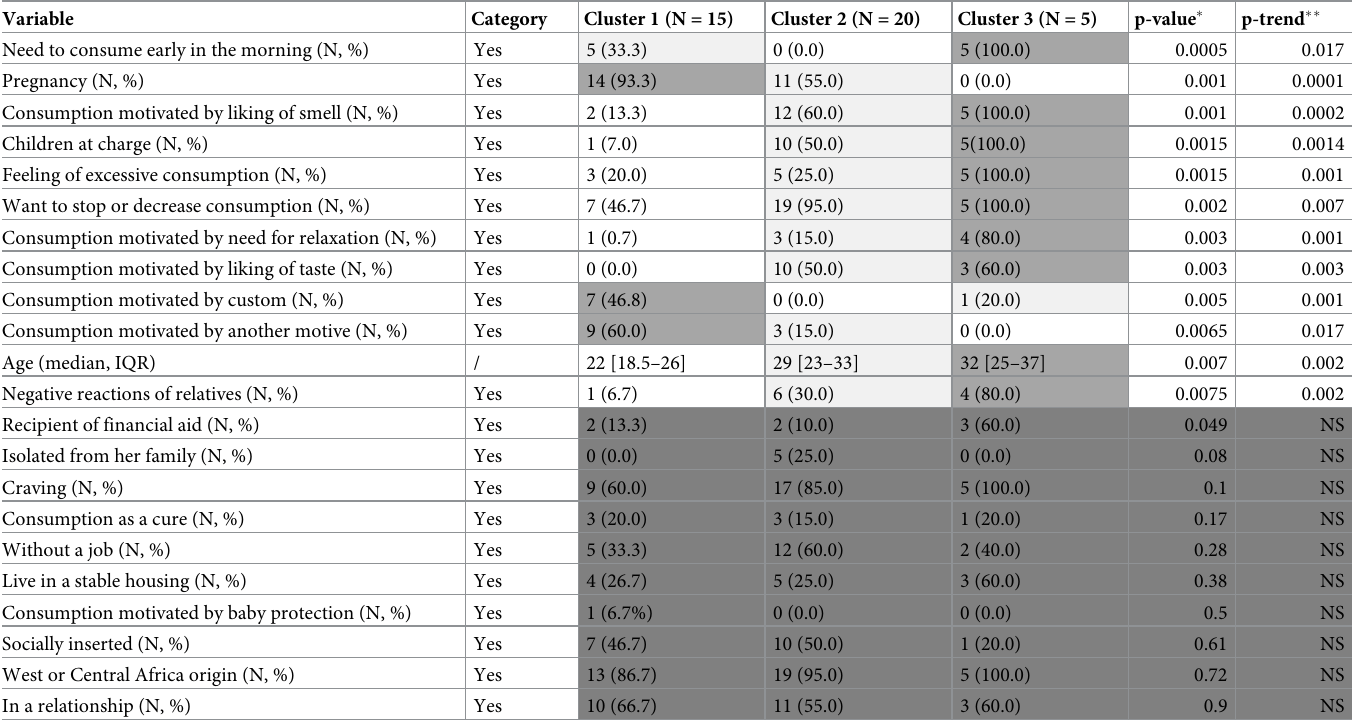
Table 6. Description of clusters identified among kaolin